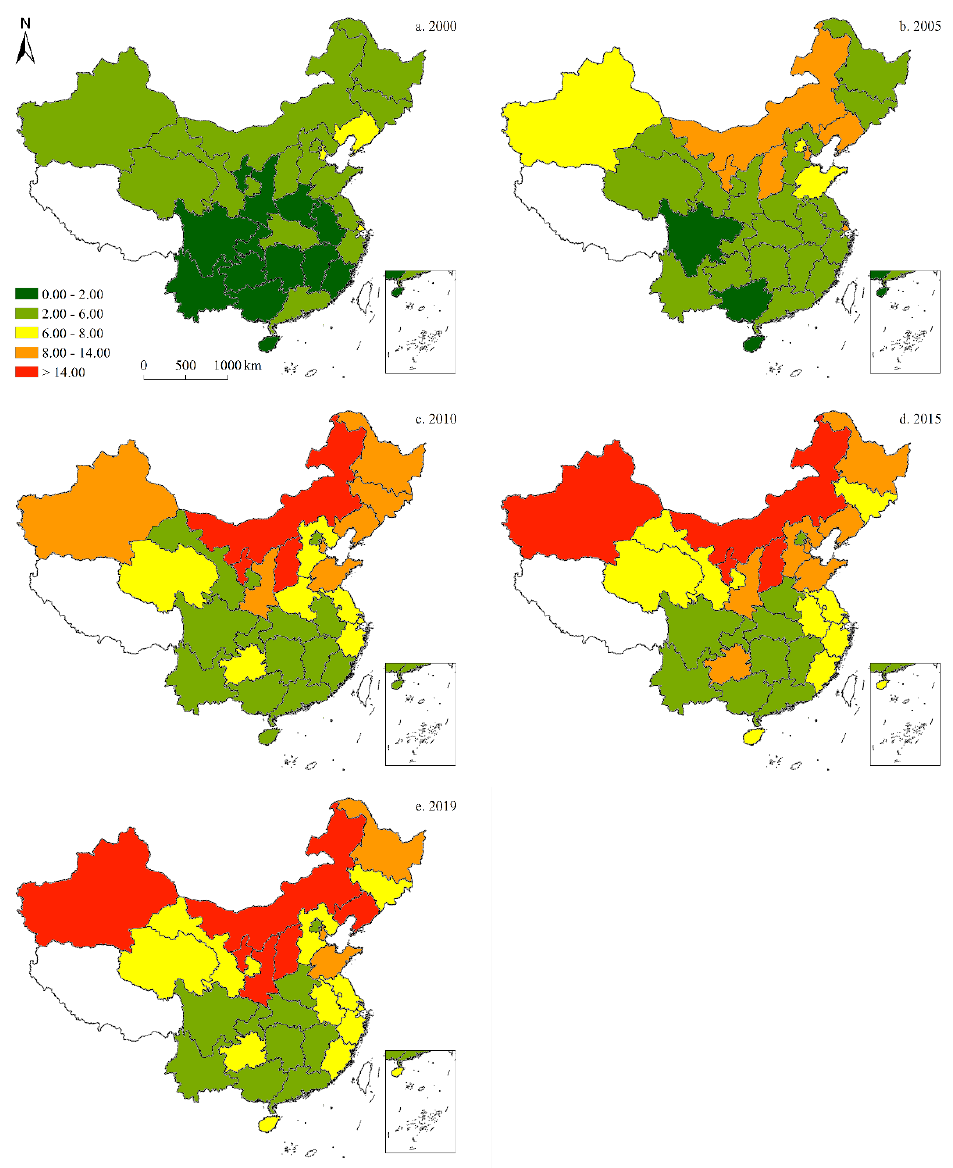
Figure 8. Spatiotemporal distribution of provincial-level CO 2 emissions per capita (in tons · person − 1 ) in China (five-time sections).